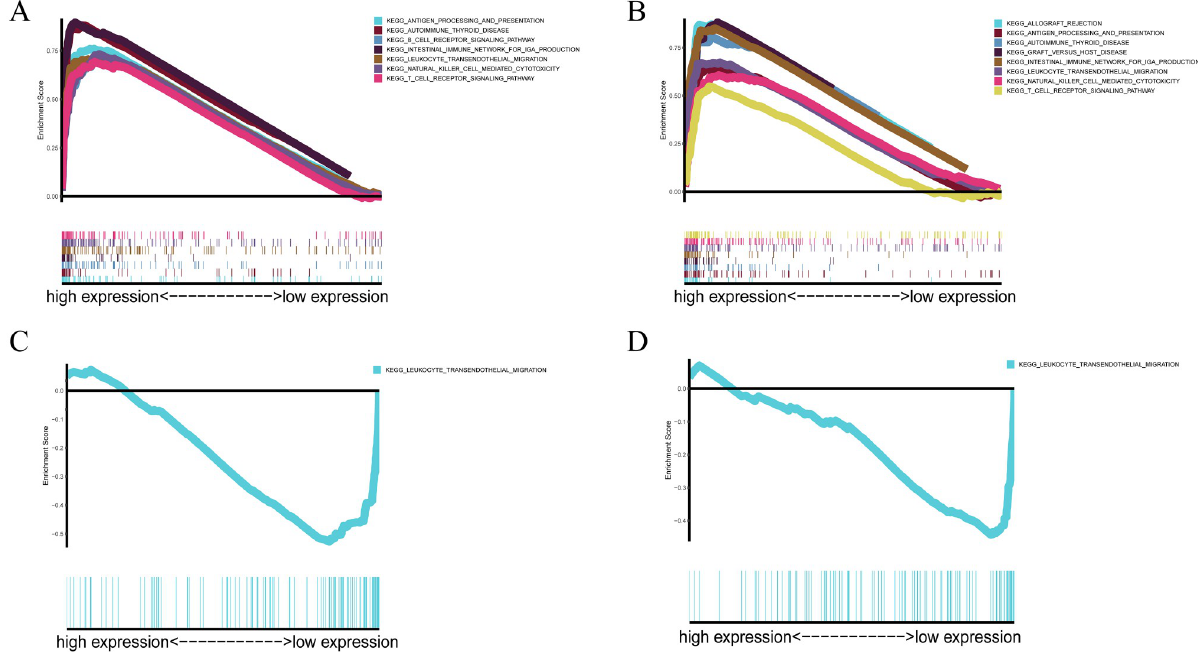
Fig 8. Multiple GSEA enrichment plots of ALOX5(A); DPP4(B); NOX1(C); PHKG2(D) in the TCGA cohort. NES, normalized enrichment score; ES, enrichment score; FDR, false discovery rate.